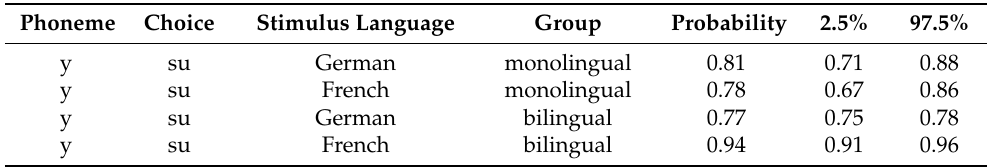
Table 11. Most probable responses given /y/ in French and German by L1 Spanish monolinguals and L1 Spanish bilinguals.